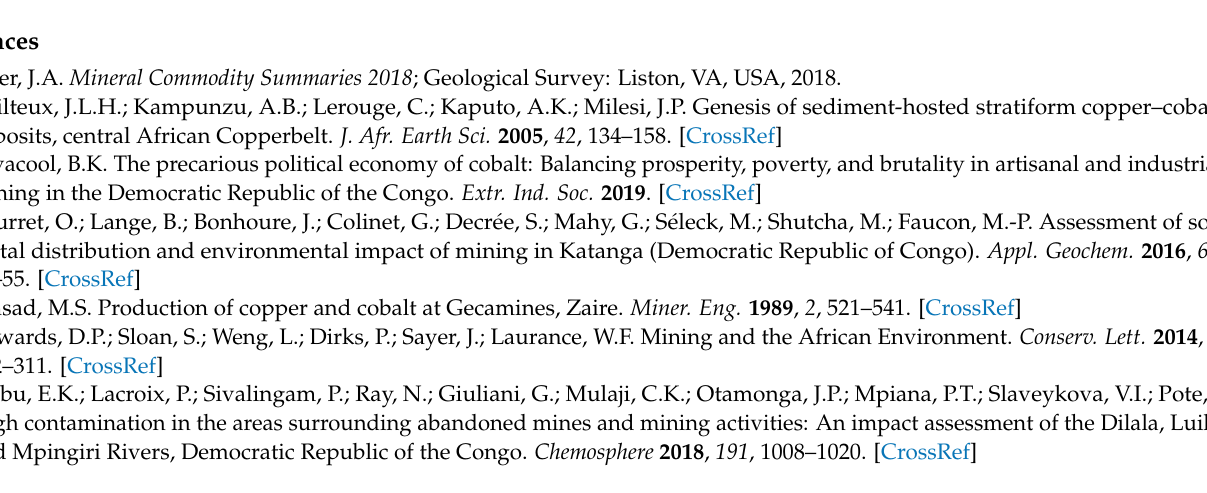
Table S1: Clinical features of subjects with dilated cardiomyopathy, Table S2: Comparison of heart failure patients to controls according to demography, education level, and routine biology, Table S3: Correlations between blood and urine metal